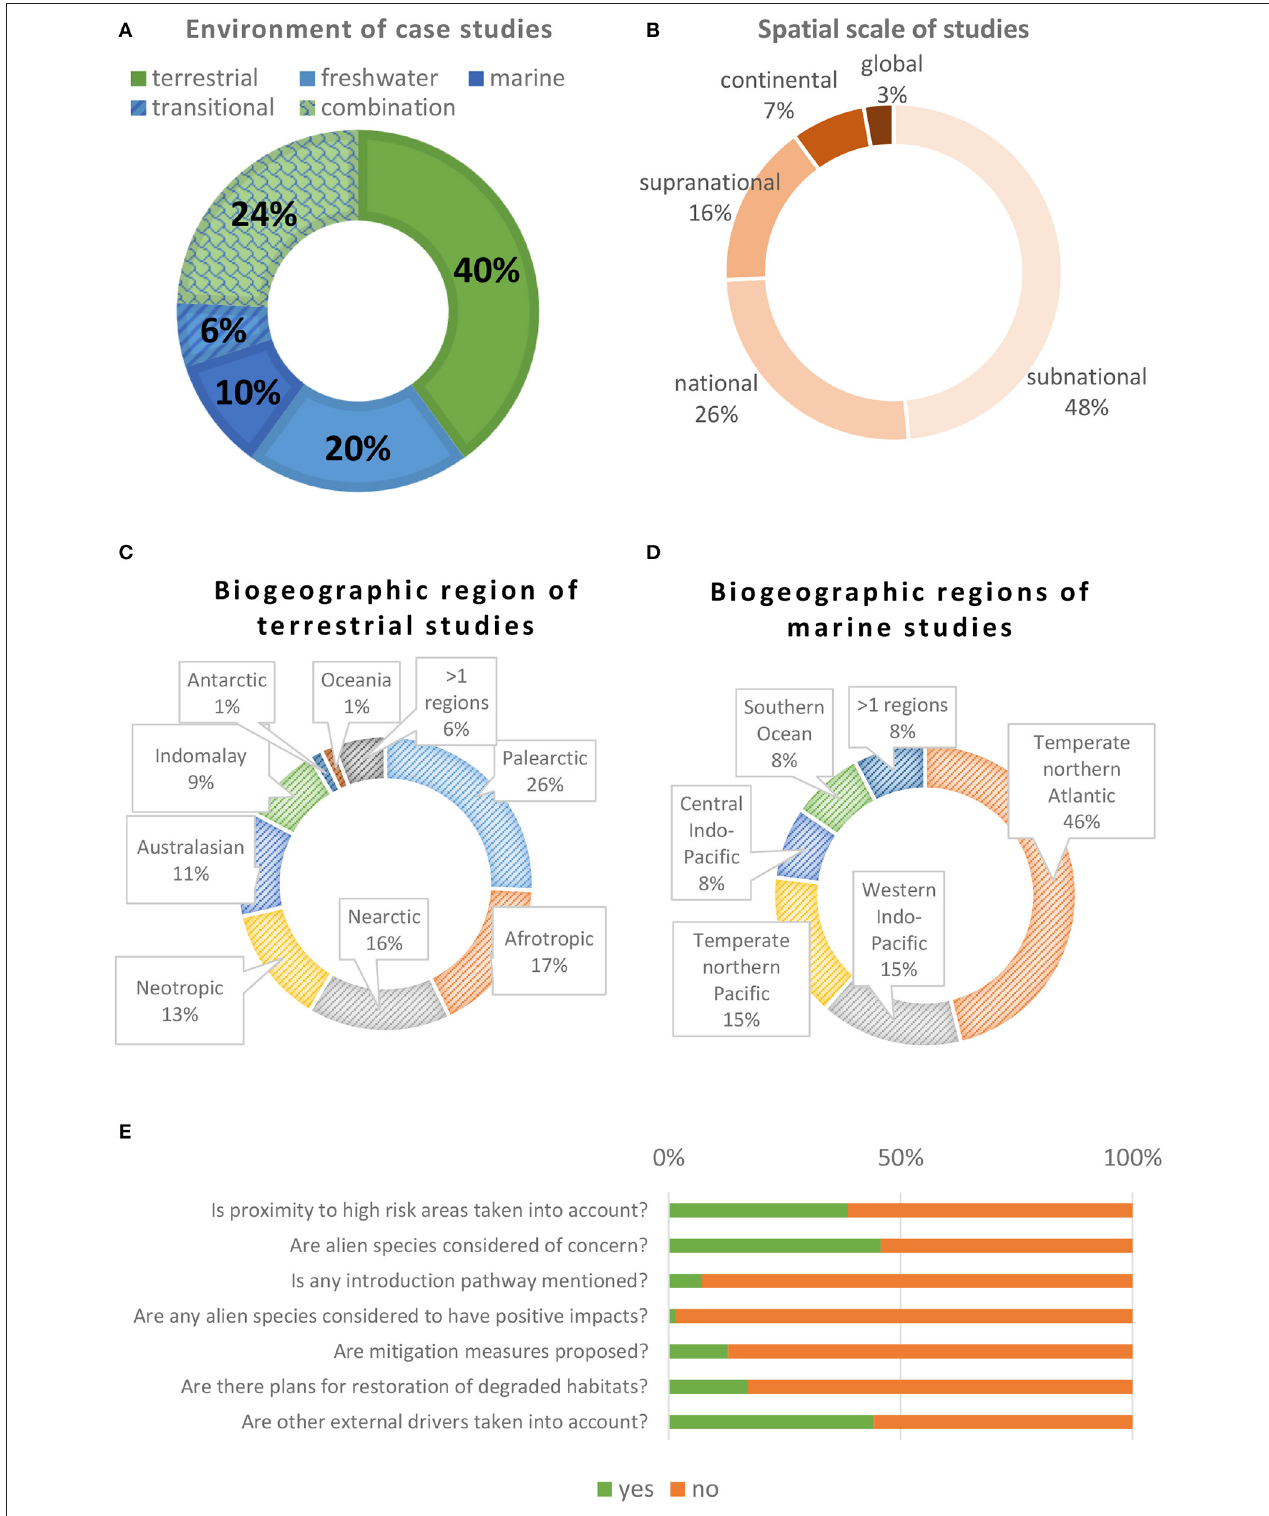
FIGURE 2 | Quantitative results of the reviewed papers. (A) Share of studies by environment. (B) Spatial scale of studies. (C) Share of studies per terrestrial biogeographic region. (D) Share of studies per marine biogeographic region. (E) Proportion of binary outcomes (yes or no) to some questions on the content of the